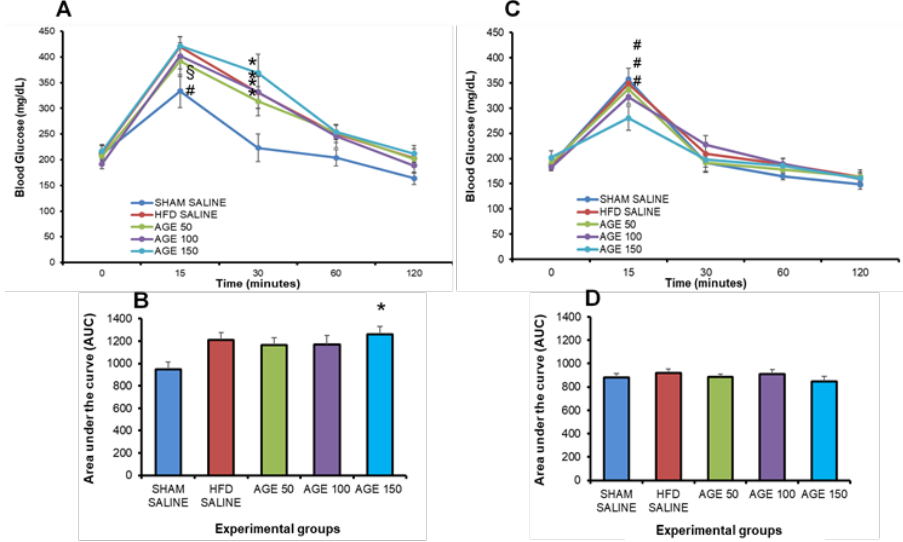
Figure 3. Evaluation of the glycemic profile before and at the end of the treatment with AGE. ( A ) Oral glucose tolerance test prior to the beginning of treatment (12th week). ( B ) Area under the curve (AUC) of blood glucose of animals evaluated prior to the beginning of treatment (12th week). ( C ) Oral glucose tolerance test at the end of treatment (24th week). ( D ) Area under the curve (AUC) of glycemia of animals evaluated at the end of treatment (24th week). SHAM SALINE: standard diet + saline solution. HFD SALINE: hyperlipidic diet + saline solution. AGE 50: hyperlipidic diet + 50 mg / kg of aqueous graviola leaf extract. AGE 100: hyperlipidic diet + 100 mg / kg of aqueous graviola leaf extract. AGE 150: hyperlipidic diet + 150 mg / kg of aqueous graviola leaf extract. Values represent mean ± mean standard error. * p < 0.05 vs. SHAM SALINE, § p < 0.05 vs. HFD SALINE, # p < 0.05 vs. AGE 150. ANOVA followed by post Tukey